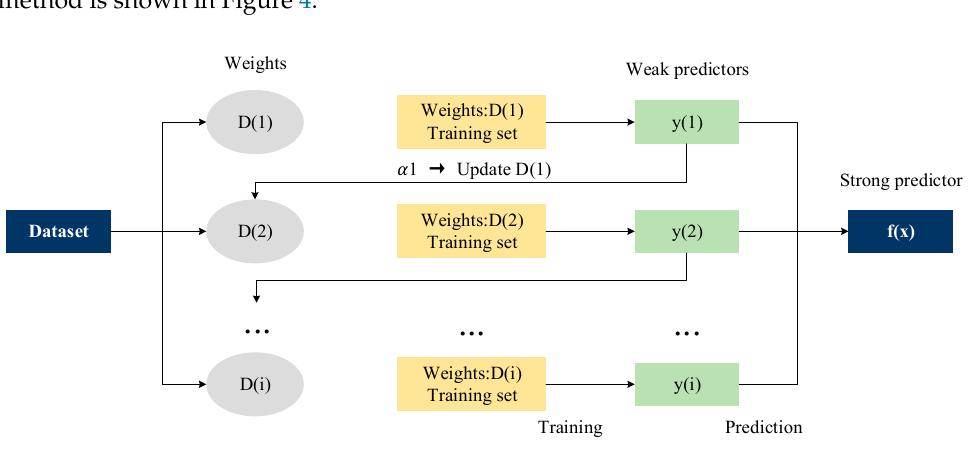
Figure 4. Schematic diagram of AdaBoost.Rt algorithm.